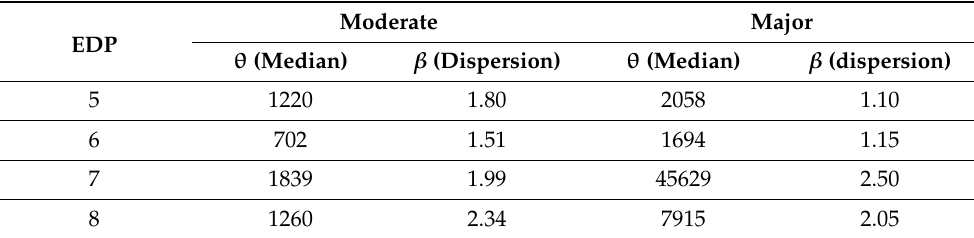
Table 7. Best Estimate Normal Distribution parameters.